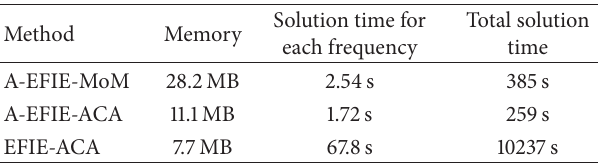
Figure 7: S11 and S12 for BPF with SRR structure. Table 3: The memory requirement and solution time for BPF with d SRR